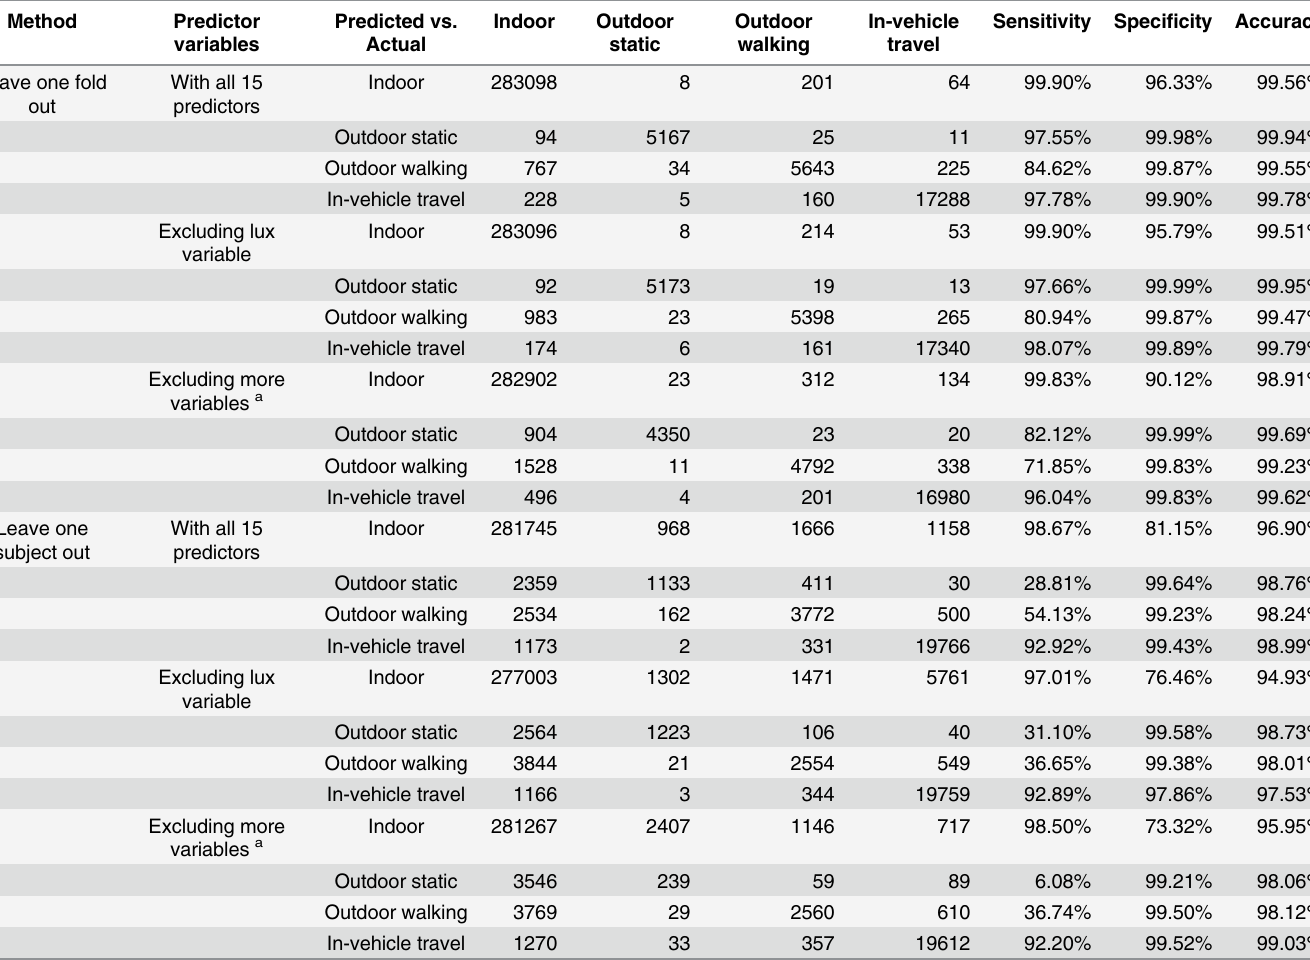
Table 1. Model validation of time-activity classification by leave-one-fold-out and leave-one-subject-out Method Predictor